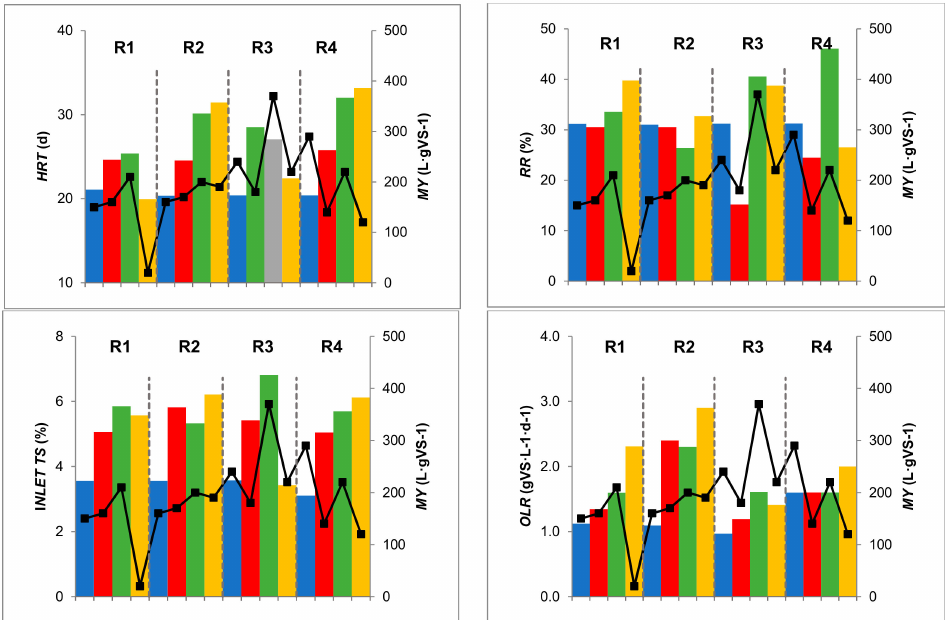
Figure 5. Comparison of methane yields ( MY ) and the hydraulic retention time ( HRT ), the recirculation rate ( RR ), the inlet total solids content ( TS ) or the organic loading rate ( OLR ). Note: Vertical grey lines denote reactors; black line denotes average values of MY registered in a whole period; blue, red, green and yellow bars denote average values of a whole period (P1, P2, P3, and P4, respectively) of the corresponding operational parameter per